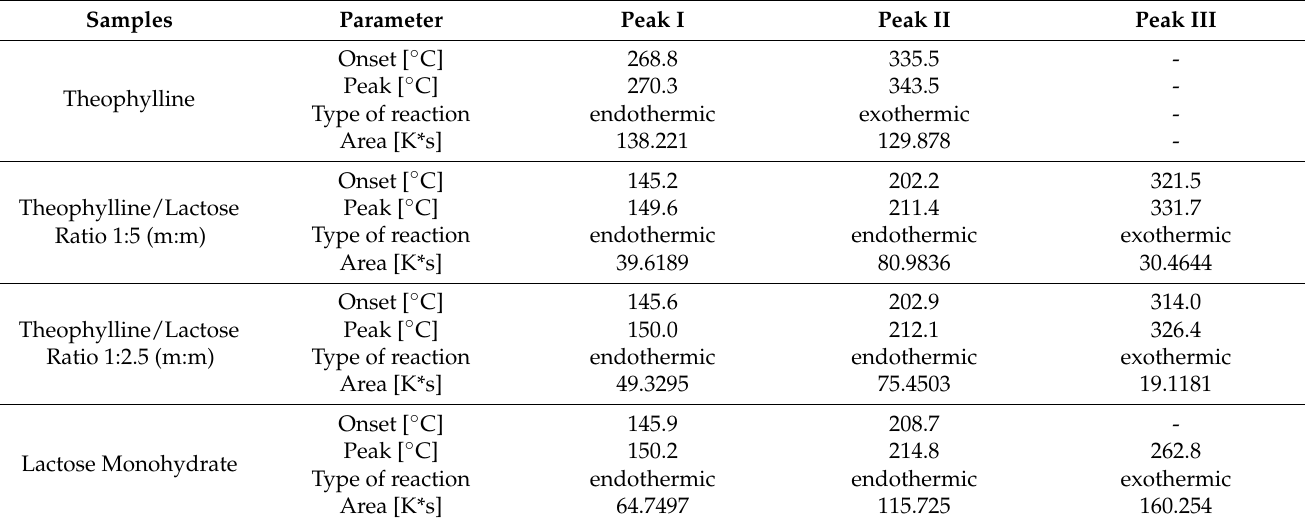
Table 5. Characteristic parameters of DTG, and D2TG curves of the tested samples.